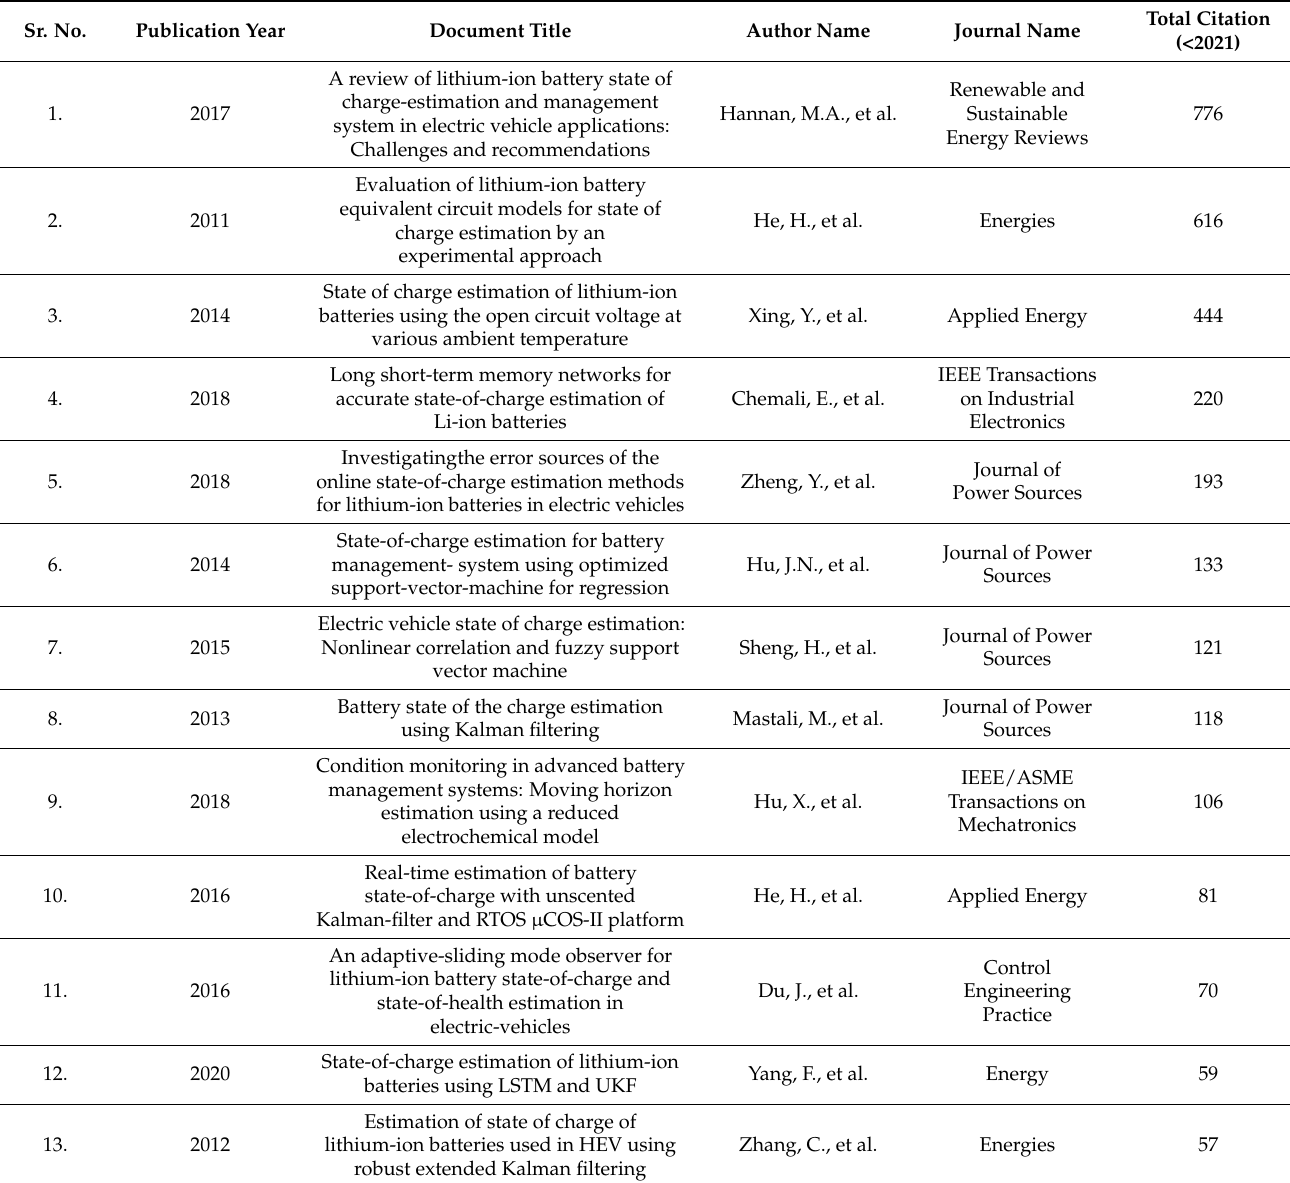
Table 8. Top 15 most cited papers in SCOPUS databases for BMS EV state